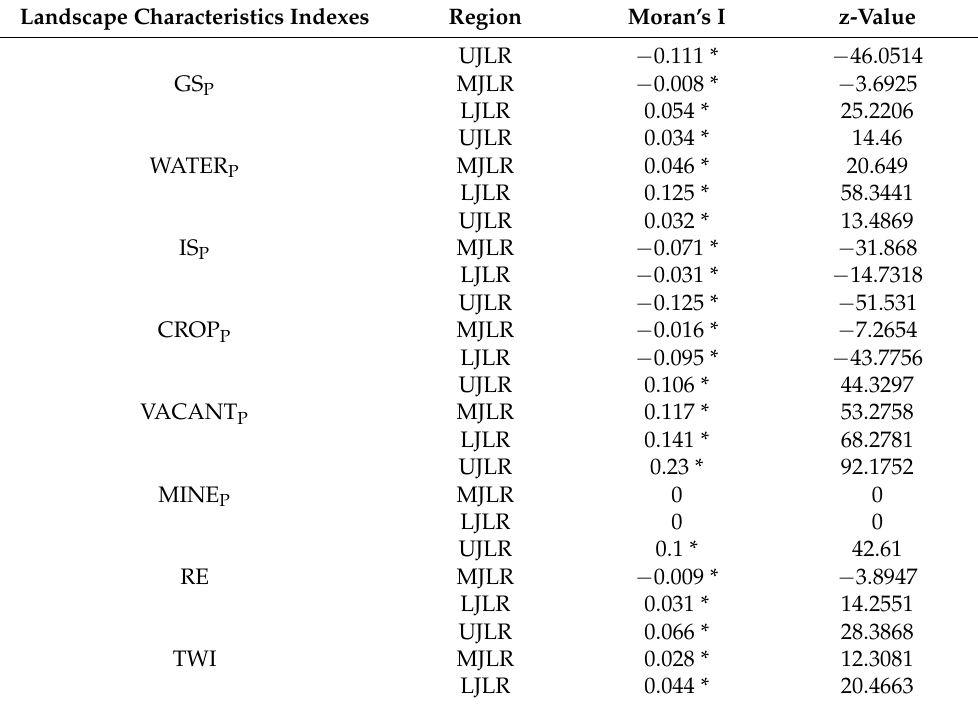
Table 4. Global bivariate Moran’s I between landscape characteristics indexes and flood inundation intensity along the Jialu